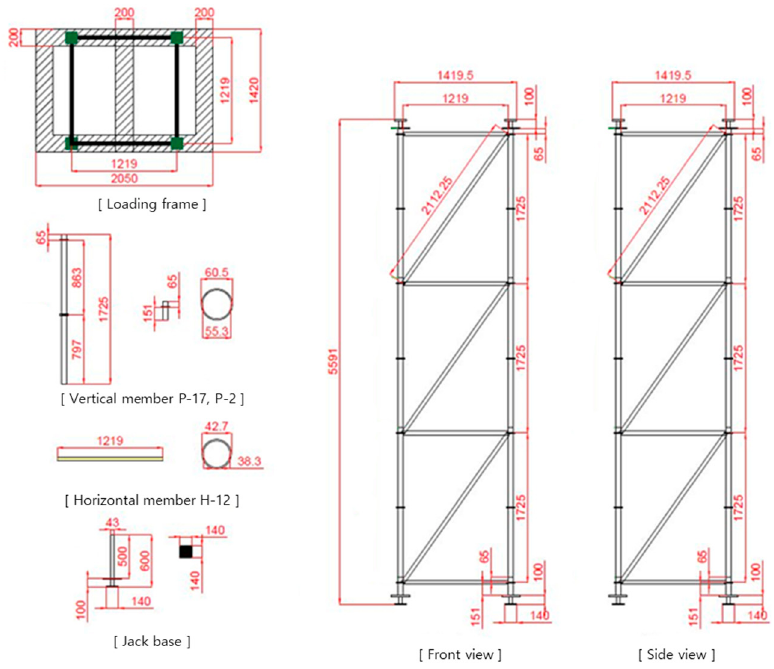
Figure 2. Test model design (Case 2, three-story assembly with braces).